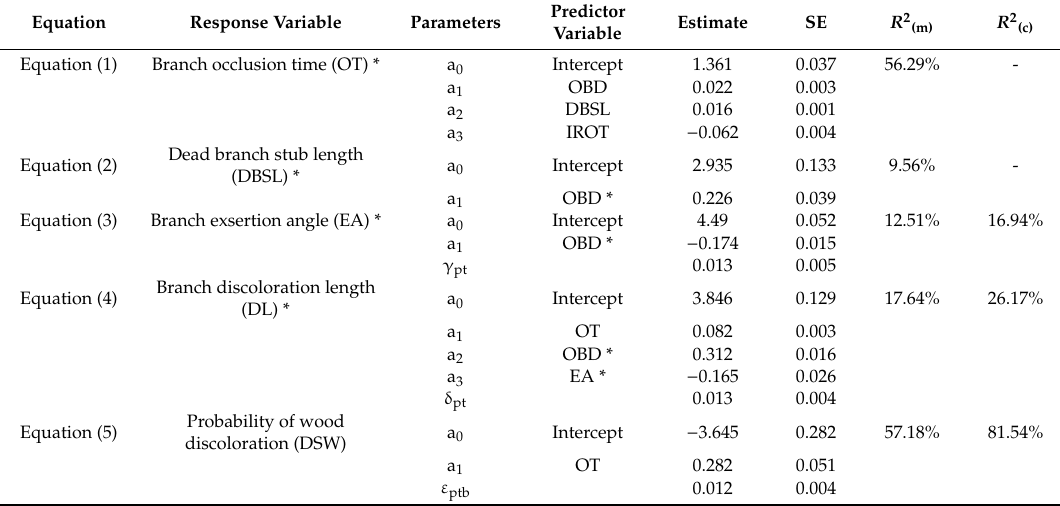
Table 4. Estimated coefficients and standard errors for equations.